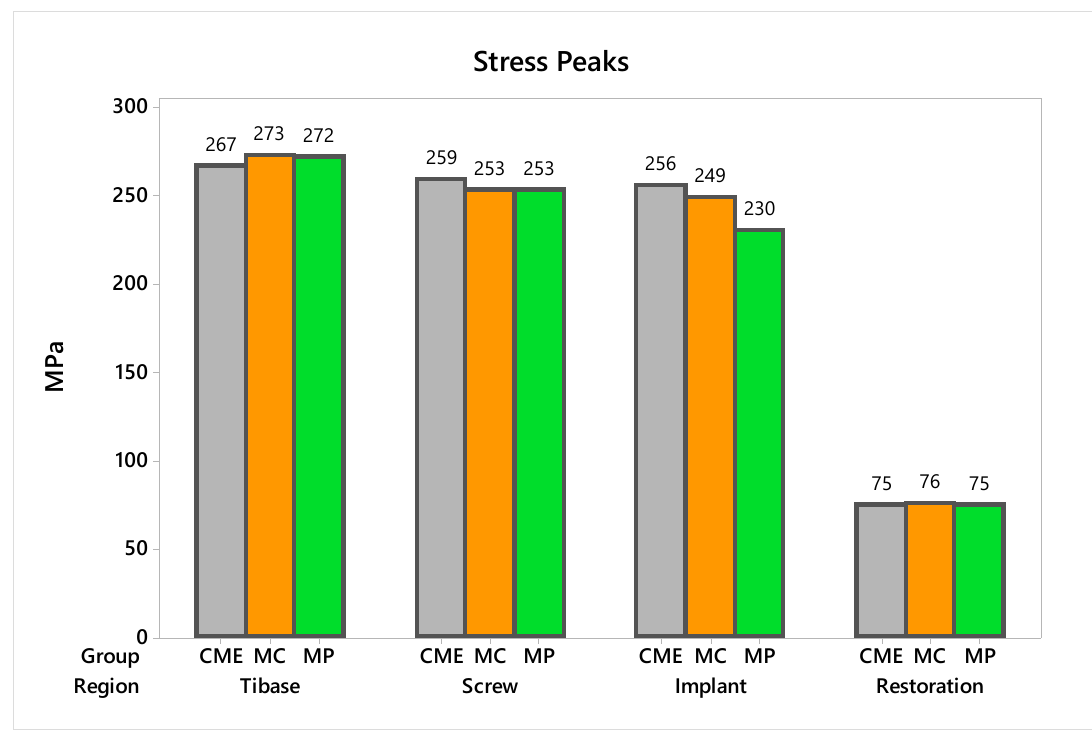
Figure 15. Stress distribution assessed by the maximum principal stress criterion according to the design of the restoration. ( a ) MC, ( b ) CME, and ( c ) MP.